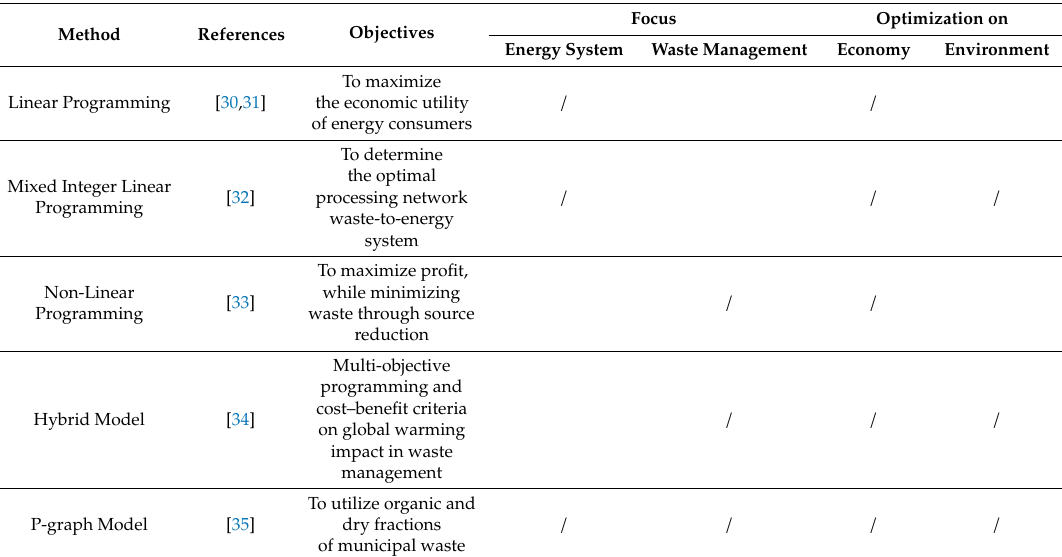
Table 1. Optimization models for solid waste